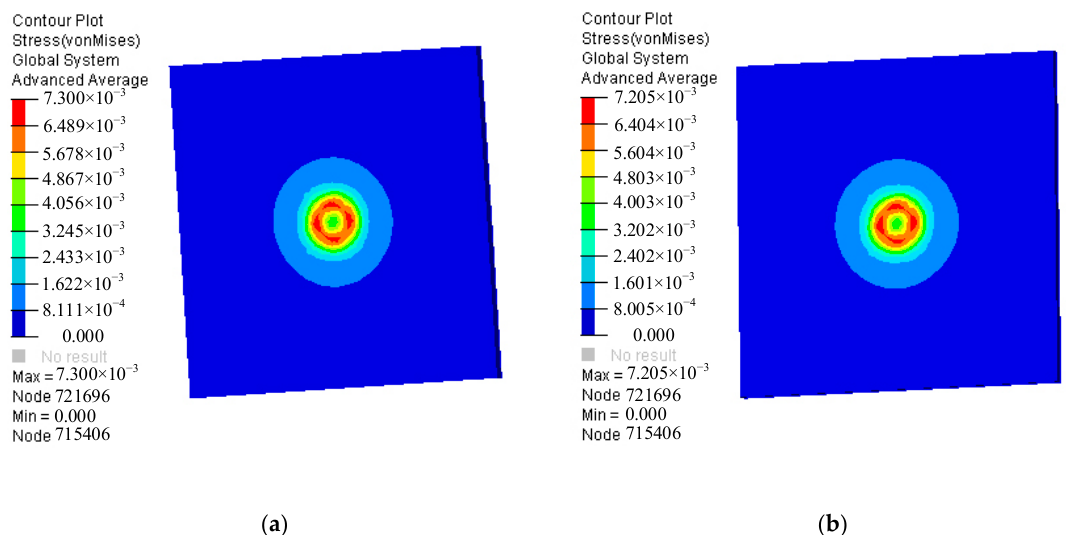
Figure 8. Maximum stress cloud image of a silicon wafer prepared by MEMS S&A device using a copper azide primer amount of ( a ) 0.429 mg and ( b ) 0.415 mg.